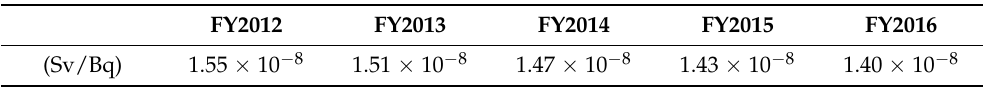
Table 3. Dose coefficients/dose conversion factors for the total radioactivity concentration of Cs-134 and Cs-137 for fiscal years (FYs)